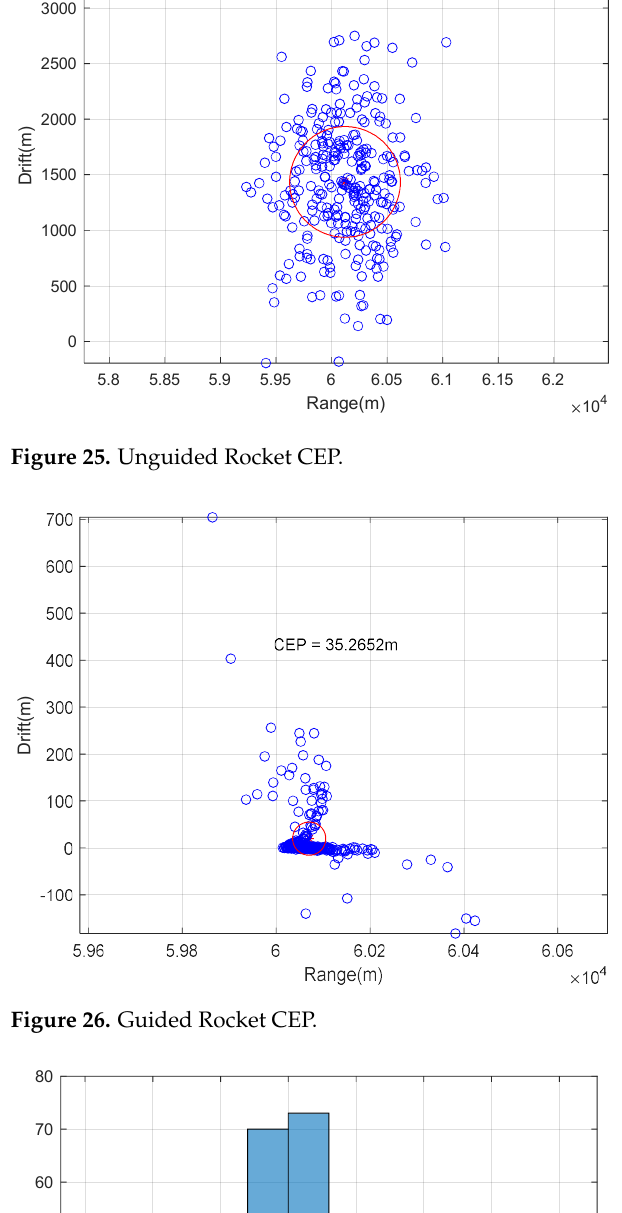
19 of 23 Figure 23. Unguided Rocket Trajectories.